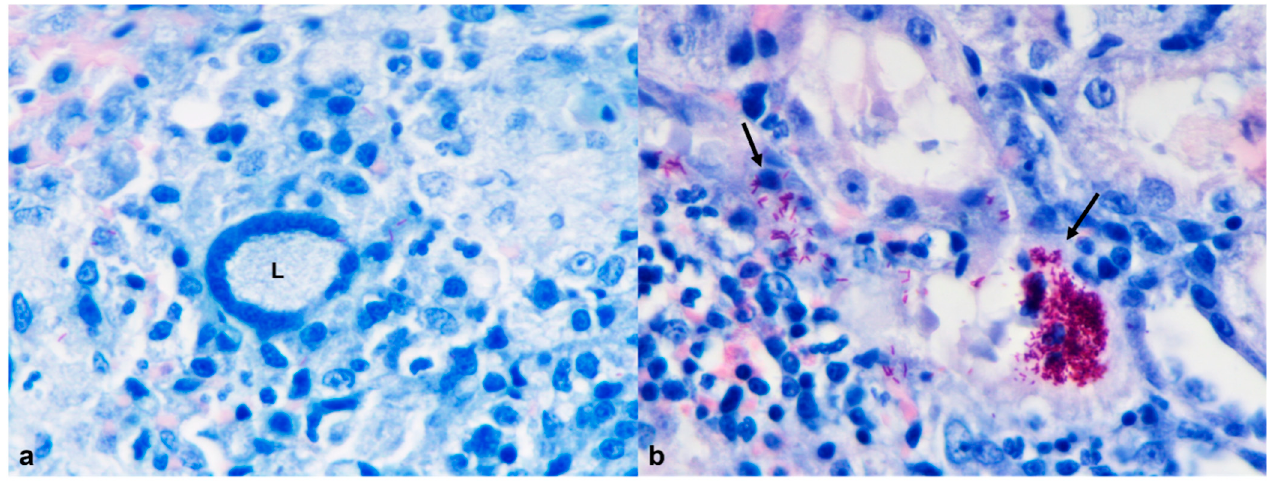
Figure 5. African pygmy hedgehog, kidney. Case 1, Mycobacterial interstitial granulomatous nephritis (Ziehl–Neelsen, 600 × ) ( a ) The inflammatory nodules contain multinucleated giant cell (Langhans type; L) admixed with mononuclear cells and rare neutrophils; ( b ) Presence of numerous acid-fast bacilli in the cytoplasm of macrophages (arrows).